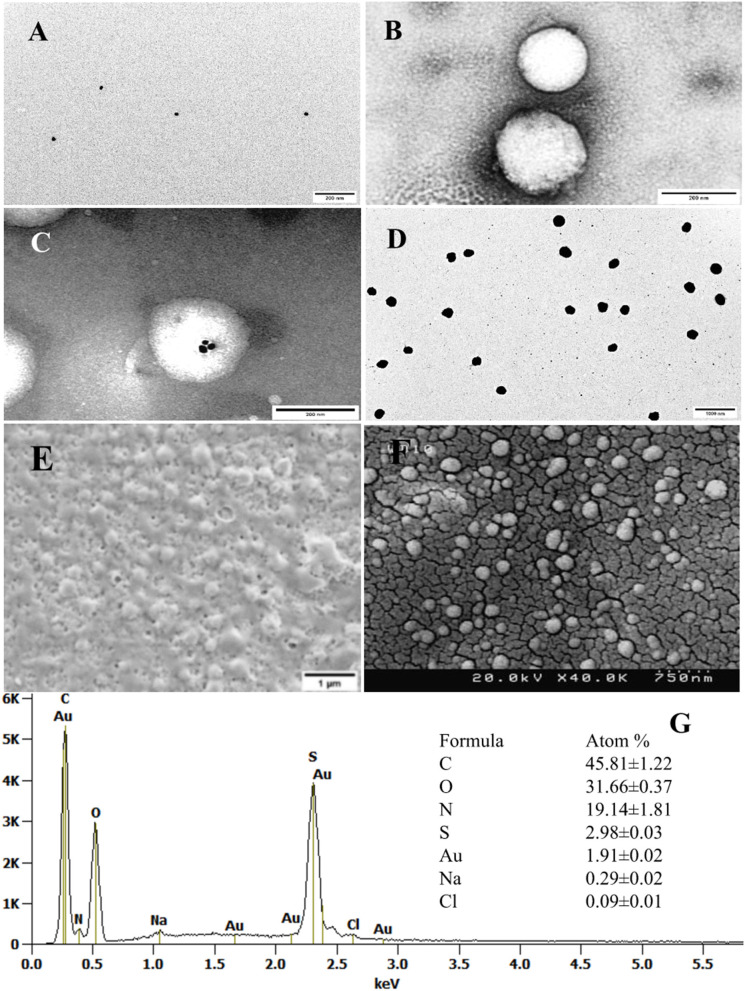
Electron micrograph and analysis. TEM images of the AuNP (A), Negatively stained Ng (B), and AuNP@ Ng with uranyl acetate (scale bar 200 nm) (C) AuNP@ Ng loaded with Curcumin without being negatively stained (scale bar 1000 nm) (D). Untreated SEM image of AuNP@Ng/Cur (scale bar 1μm) (E). Gold sputter-coated AuNP@Ng/Cur FESEM image (scale bar 750 nm) (F). EDX spectrum and quantitative atom% information of AuNP@Ng/Cur (G).